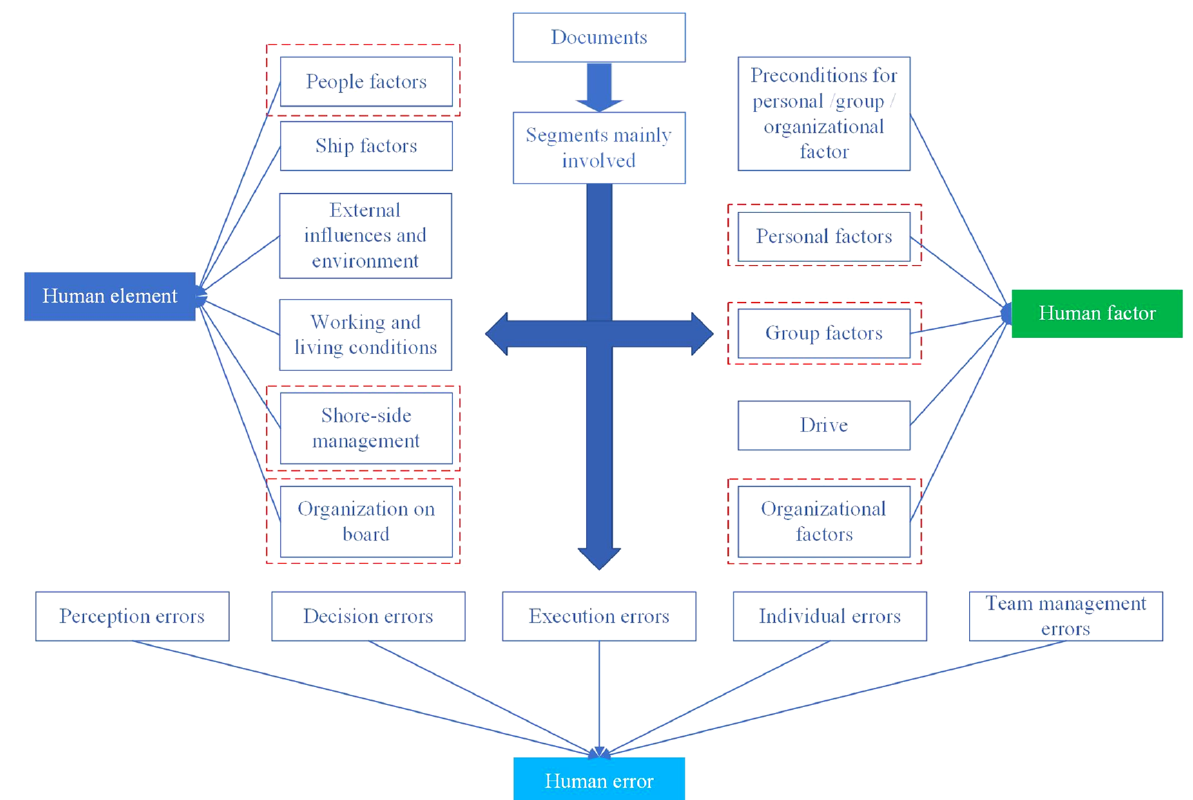
Figure 6. The usage characteristics of the three terms.